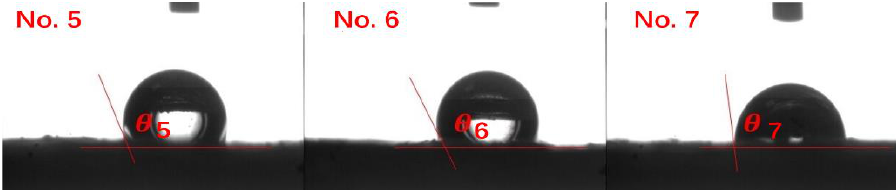
Figure 12. Contact angle measurement of LCC specimens No. 5 – 7.